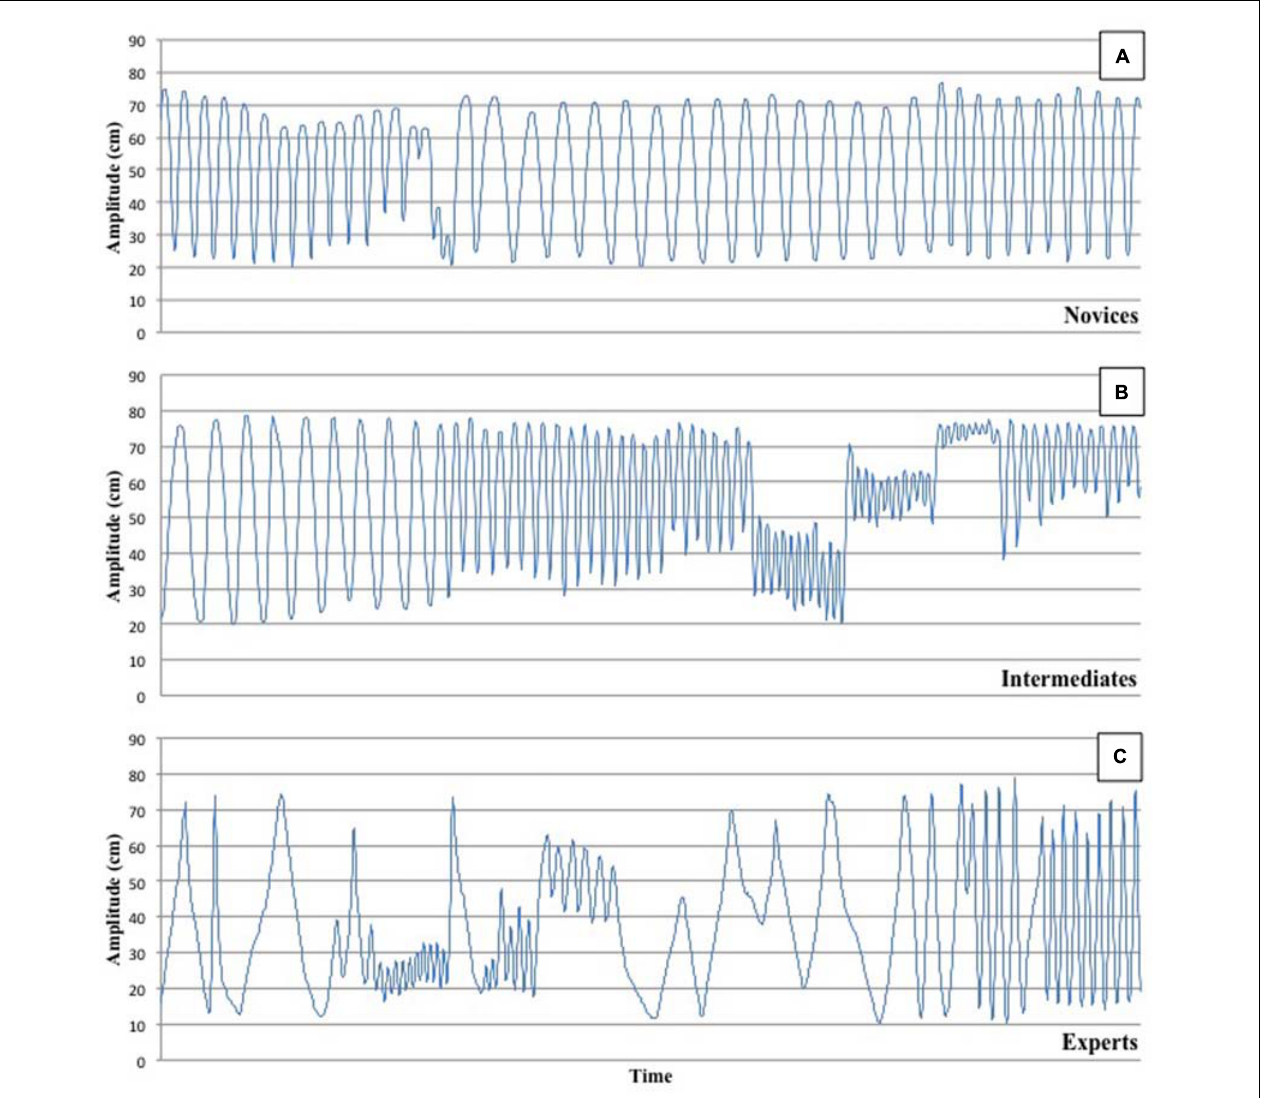
FIGURE 1 | Representative example of typical movements performed by each of the 3 groups – A = Novices, B = Intermediates, and C = Experts. One can observe an increase of the number and spread of frequencies from Novices to Experts as well as more frequent turn over of their movements (c.f. Duration of